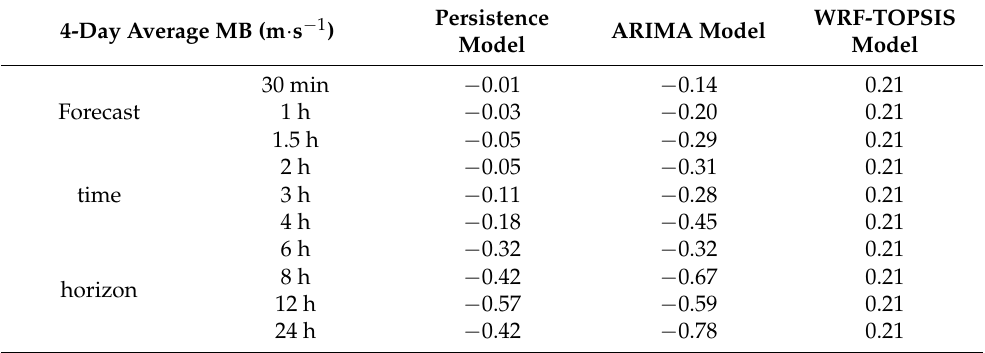
Table 7. Four-day average mean bias for the wind speed forecasting using the persistence, au- toregressive integrated moving average (ARIMA), and WRF-TOPSIS models applied to the 4-day test dataset.